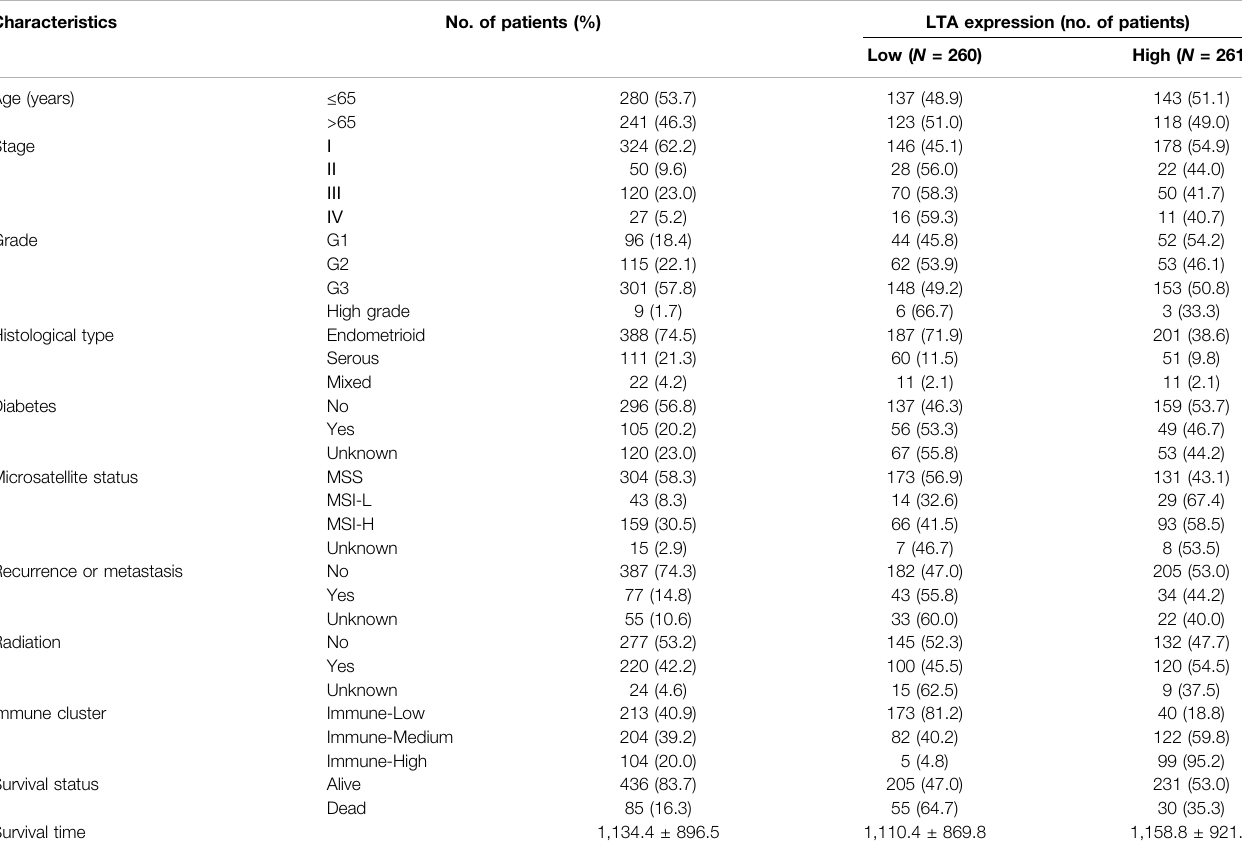
TABLE 1 | The basic information of subjects in the study.